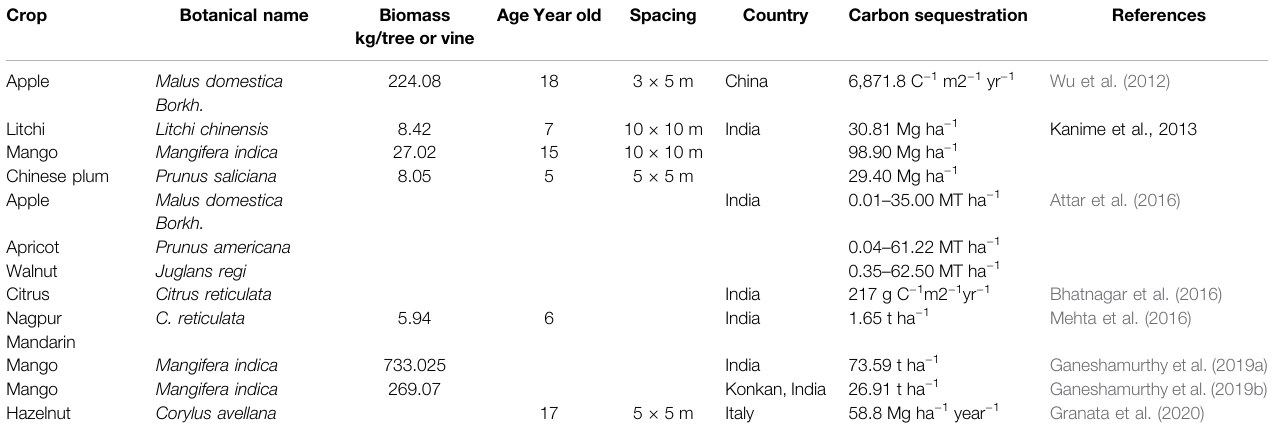
TABLE 2 | Effect of different fruit tree species on biomass and carbon sequestration with special reference to age and spacing. Crop Botanical name Biomass Age Year kg/tree or vine